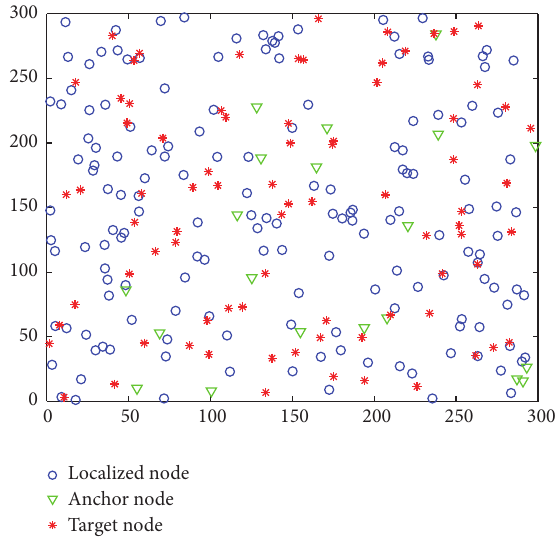
Figure 3: MBA for WSN localization.